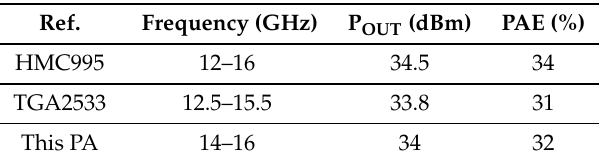
Figure 13. CW power performance vs. frequency for the amplifier. Drain bias voltage and current are 30 V and 30 mA, respectively. Measurements: symbols, simulations: solid lines. Table 2. Comparison between the designed 15 GHz Gallium Nitride (GaN) PA and commercial gallium arsenide (GaAs)